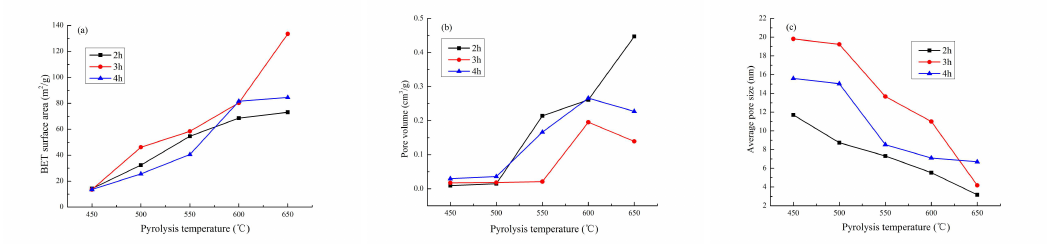
Figure 3. E ff ects of di ff erent pyrolysis processes on BET surface area and pore size analysis of Caragana korshinskii biochar (CB). ( a ) BET surface area, ( b ) pore volume, ( c ) average pore